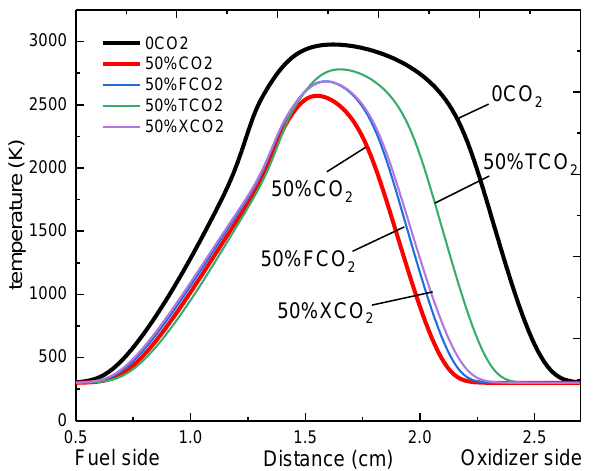
Figure 3. The comparison of the effect of the three artificial species on the flame temperature at p = 1 atm; 𝛼 𝑠 = 10 s −1 ; β = 0%, 50%.